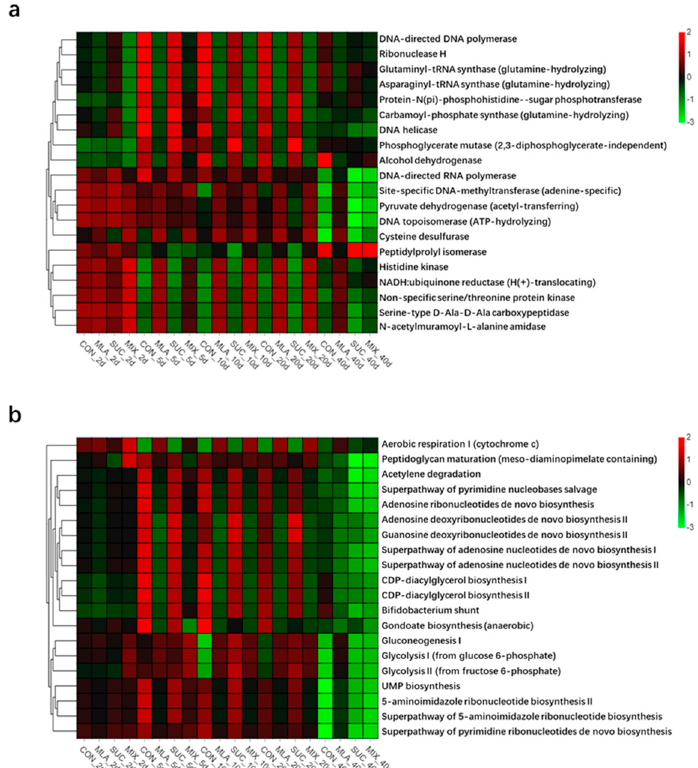
Figure 3. Heatmap of the top 20 predicted functions ( a ) and pathways ( b ) of the bacterial communities analyzed via PICRUSt. CON, control group; MLA, 1% malic acid addition on the fresh weight (FW) basis; SUC, 1% sucrose addition on the FW basis; MIX, 1% malic acid and 1% sucrose addition on the FW basis.